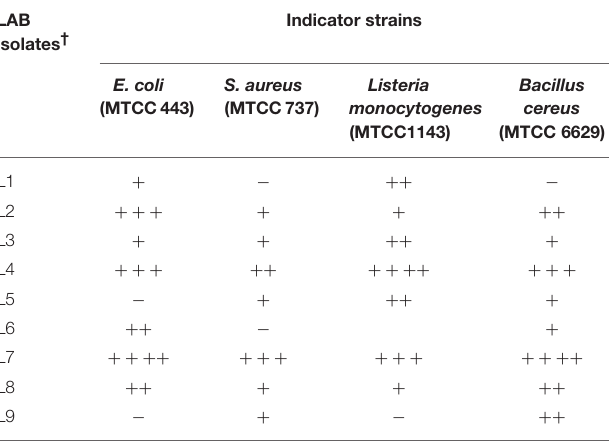
TABLE 3 | Antagonistic activity of culture supernatants of LAB strains against pathogenic bacteria.